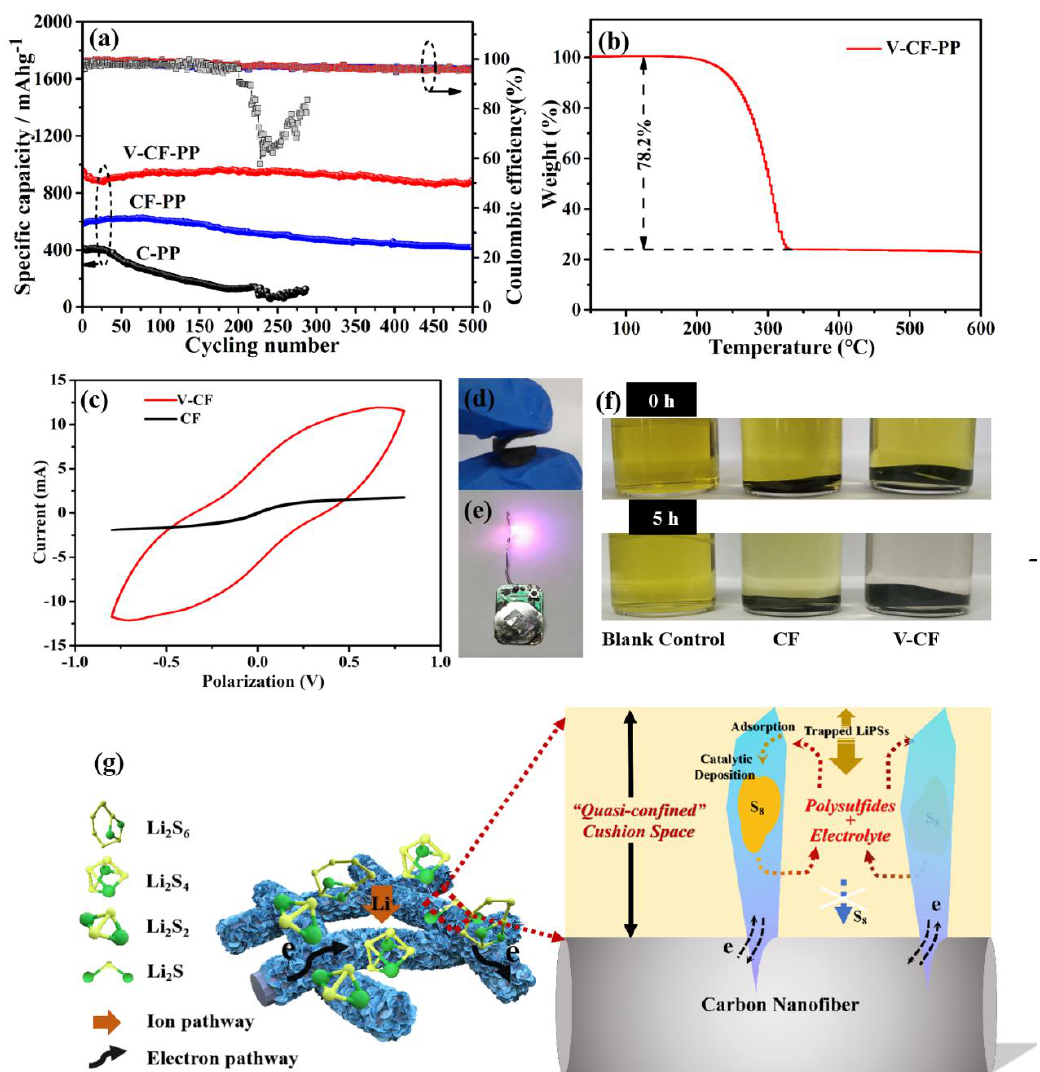
Figure 5. ( a ) Long-term cycling performance at 1 C for different batteries, ( b ) thermogravimetric (TG) analysis of the sulfur loadings in CF/S cathodes, ( c ) CV of symmetric cells using the CF and the V-CF membranes as the corresponding symmetric electrodes, ( d ) the flexibility test of the V-CF interlayer, ( e ) V-CF-PP battery lighting the diode, ( f ) photographs show the adsorption of Li 2 S 6 in 1 M LiTFSI of 1,3-dioxolane (DOL)/dimethoxyethane (DME) electrolyte solution, and ( g ) the illustration for the cycling stability derived from a quasi-confined cushion space in the V-CF interlayer.